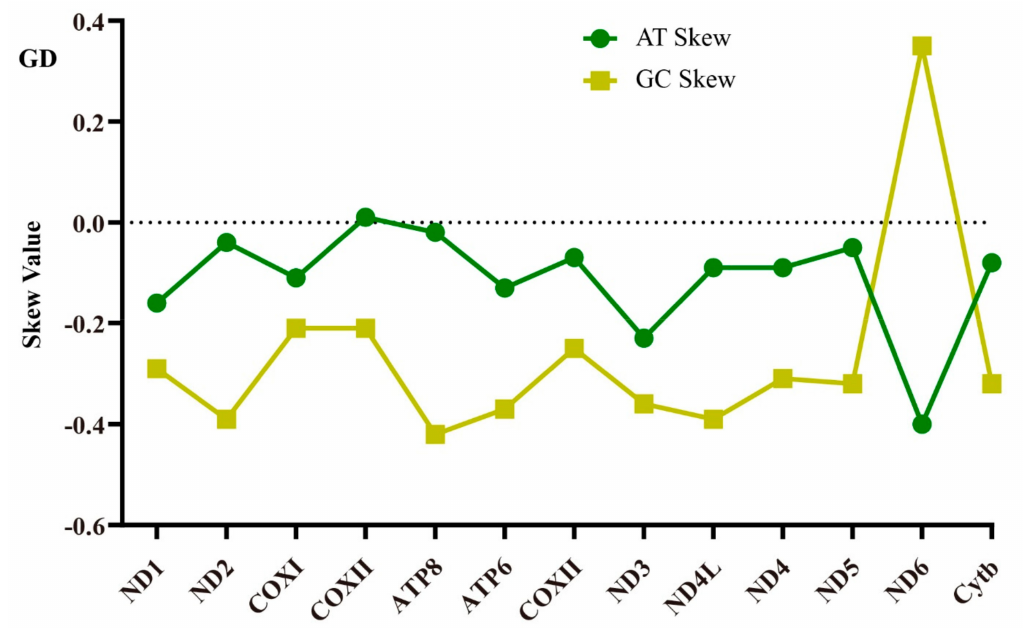
Figure 3. The AT / GC skew value of 13 PCGs of for G. filamentosus (GF), G. erythrourus (GE), and G. decacanthus